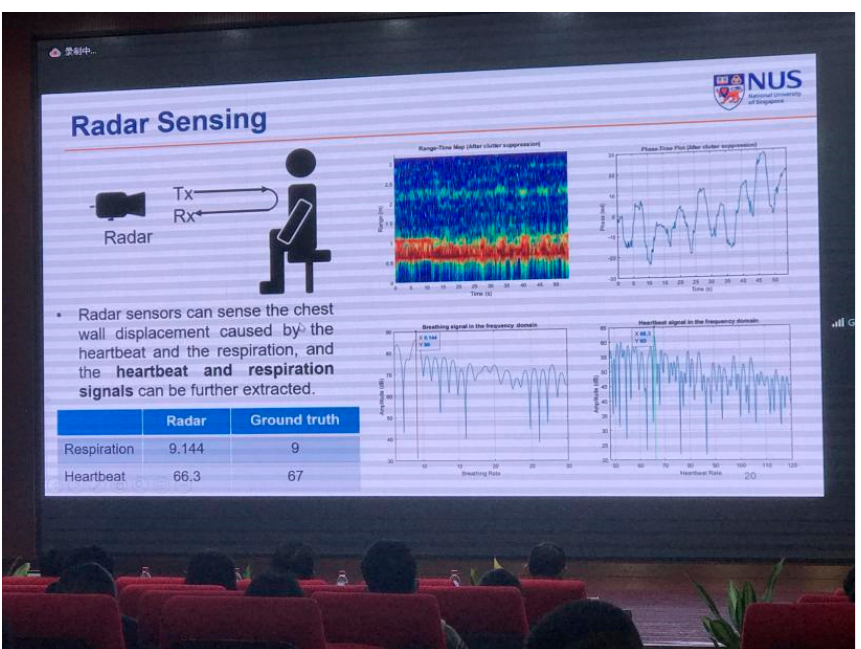
Figure 1. The speech of Professor Guo Yong-xin: Fall Detection using Radar Sensors for the old.